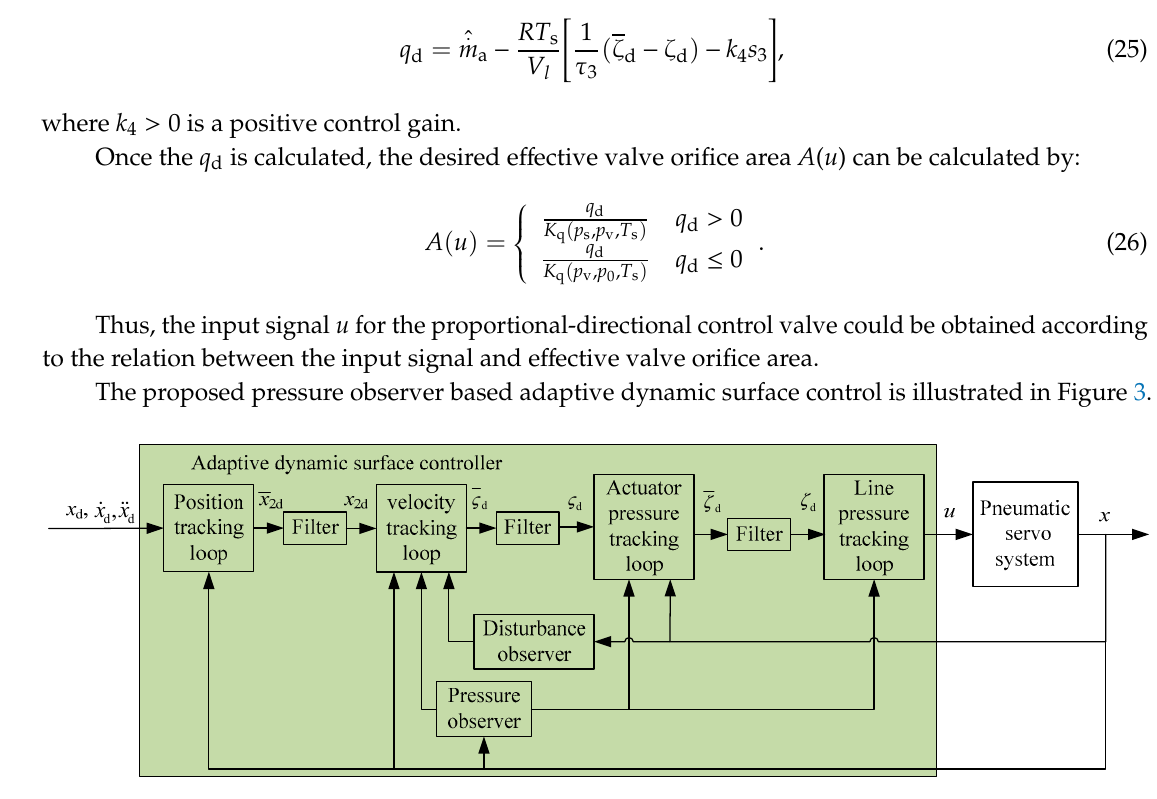
Figure 3. Block diagram of the control system.